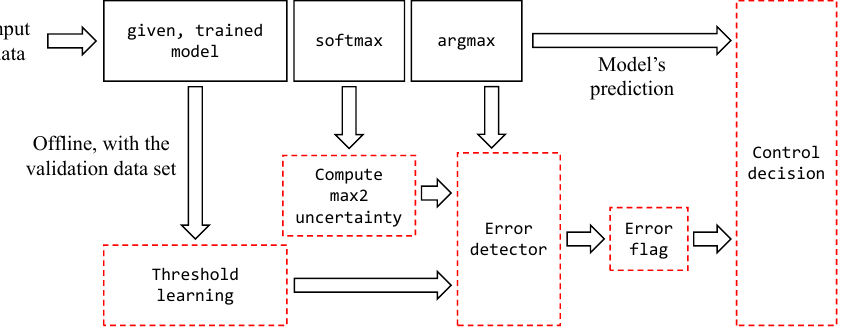
Figure 4. The proposed UFrame operates as a wrapper module for the given trained neural network model. UFrame includes the components inside the red dotted box, whereas the rest of the boxes in black solid lines belong the regular workflow of a general neural network model using softmax